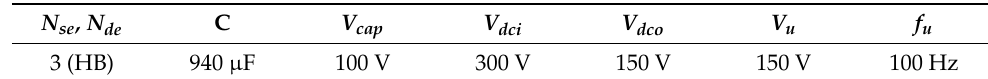
Figure 7. Experimental test bench. Table 1. MMC parameters.